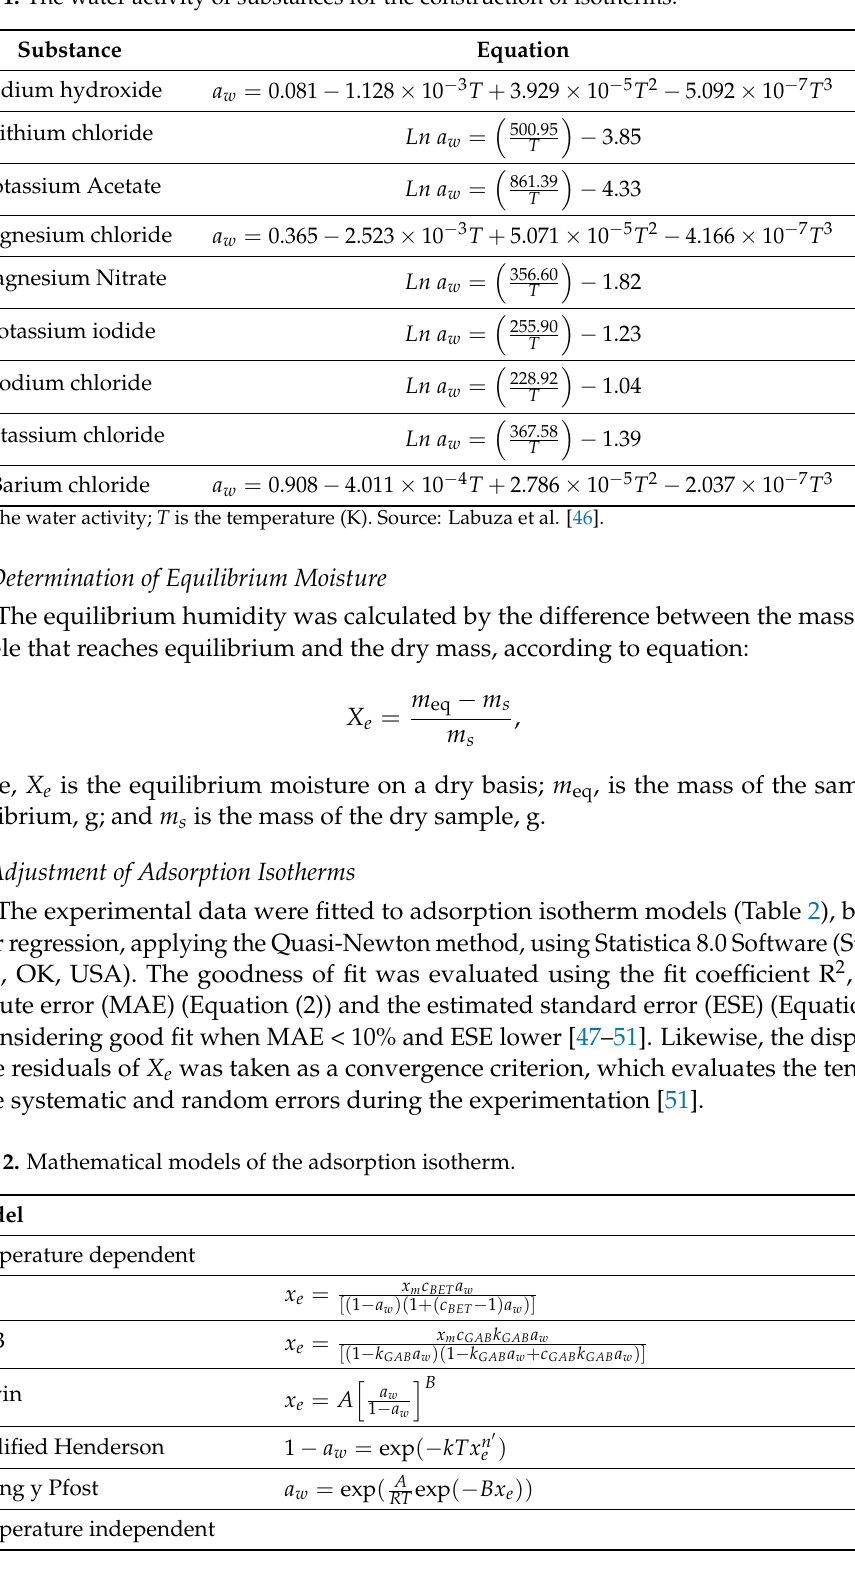
Table 1. The water activity of substances for the construction of isotherms.